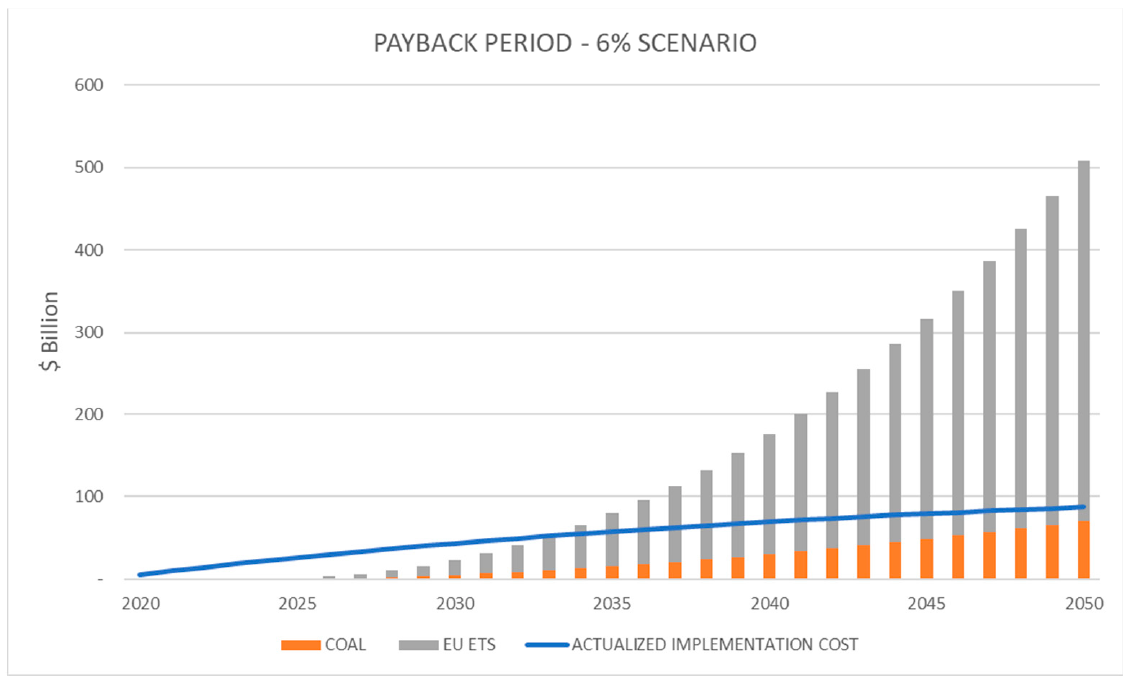
Figure 9. Payback period in the 6% scenario.